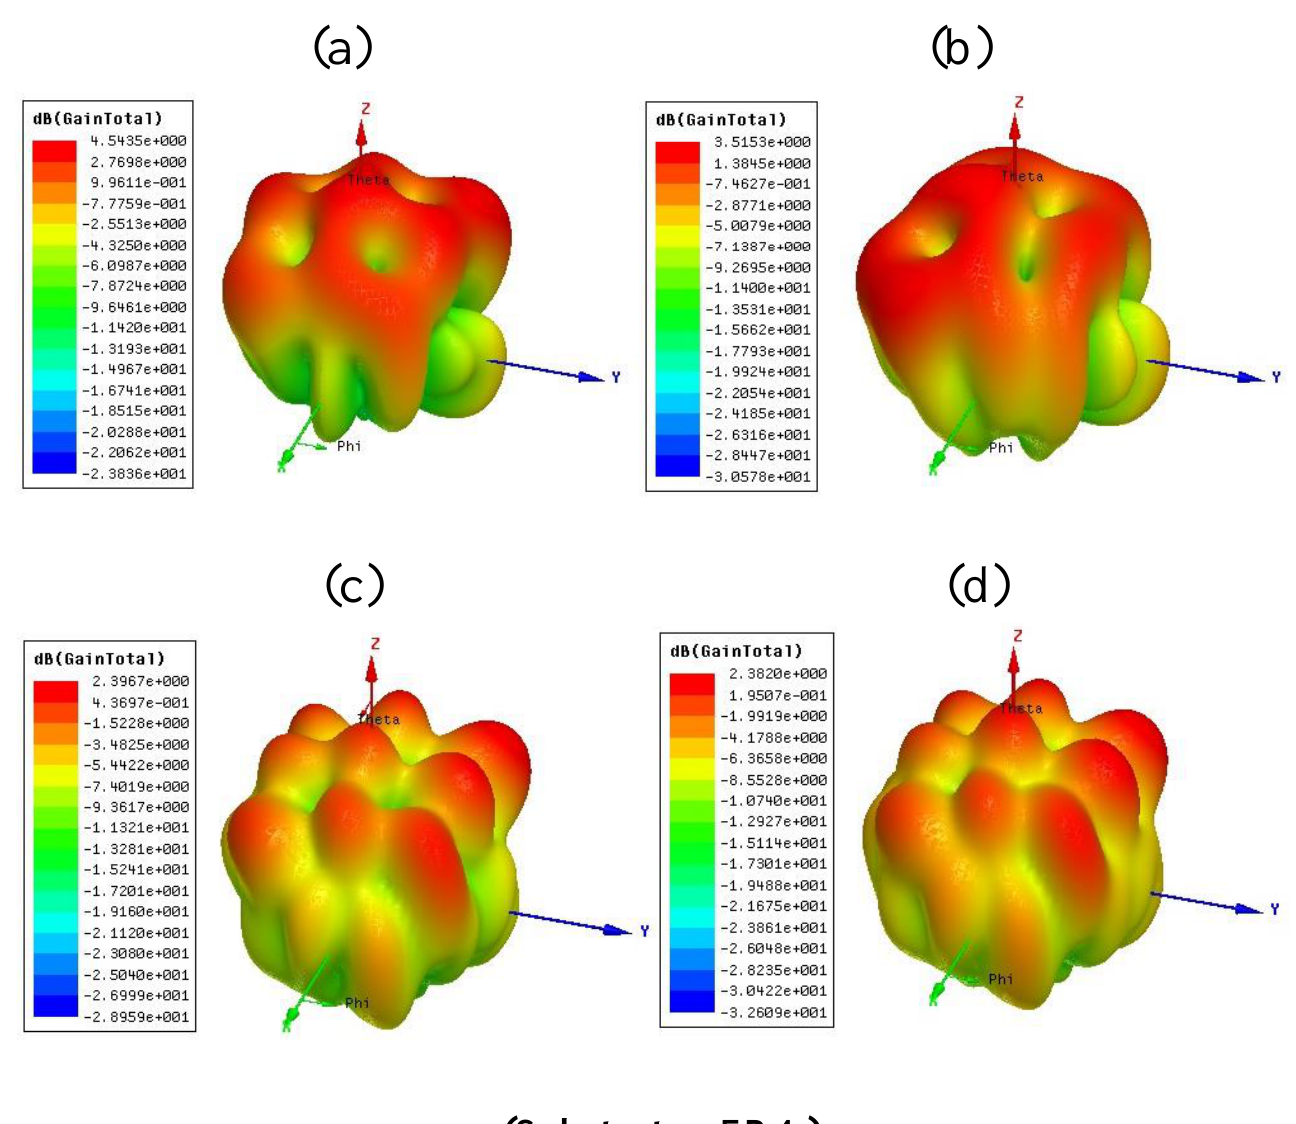
Figure 11. Total gain for the presented four antenna structures by selecting the substrate FR4. ( a ) 4.54 dB for the CPIO and SWT ( b ) 3.51 dB for the CPIO and SWOT ( c ) 2.39 dB for the DCPIO and SWT ( d ) 2.38 dB for the DCPIO and SWOT. Table 5. Comparison of the proposed structure with another multiband design.